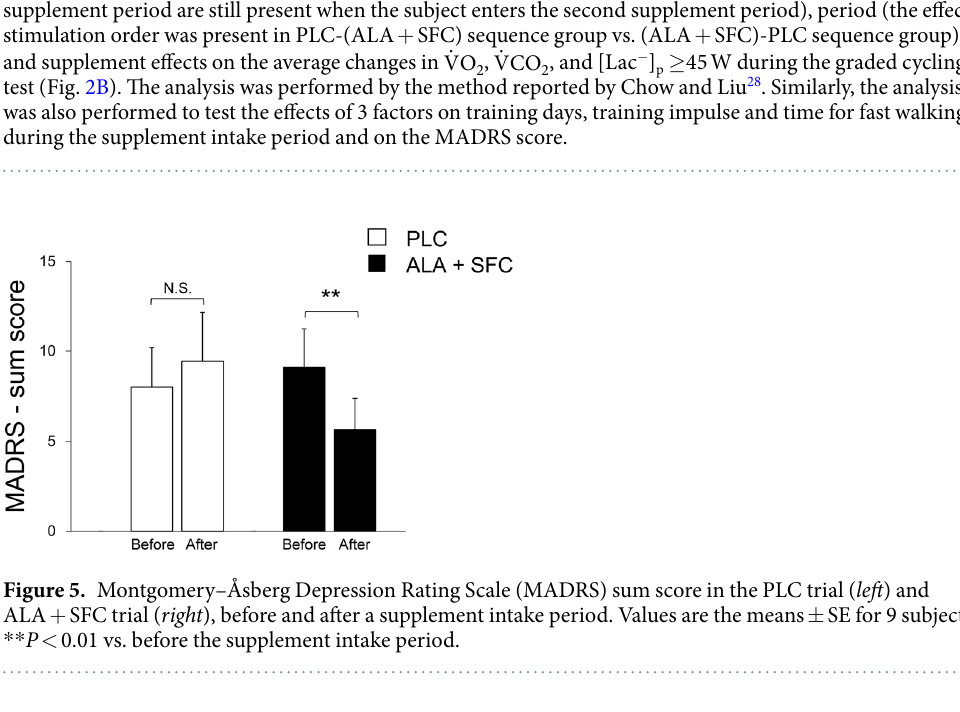
** P < 0.01 vs. before the supplement intake period.